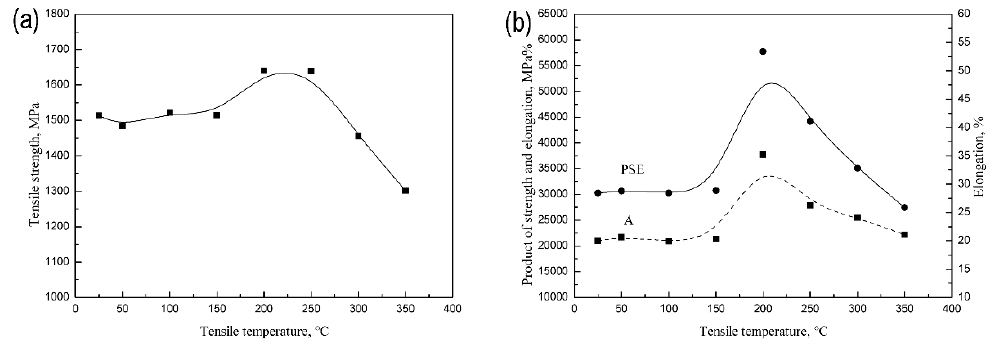
Figure 1. Tensile properties of the quenching-partitioning-tempering (Q-P-T) martensitic steels with an increased test temperature: ( a ) the ultimate tensile strength (UTS) ( b ) the total elongation (A), and the products of strength and elongation (PSE)